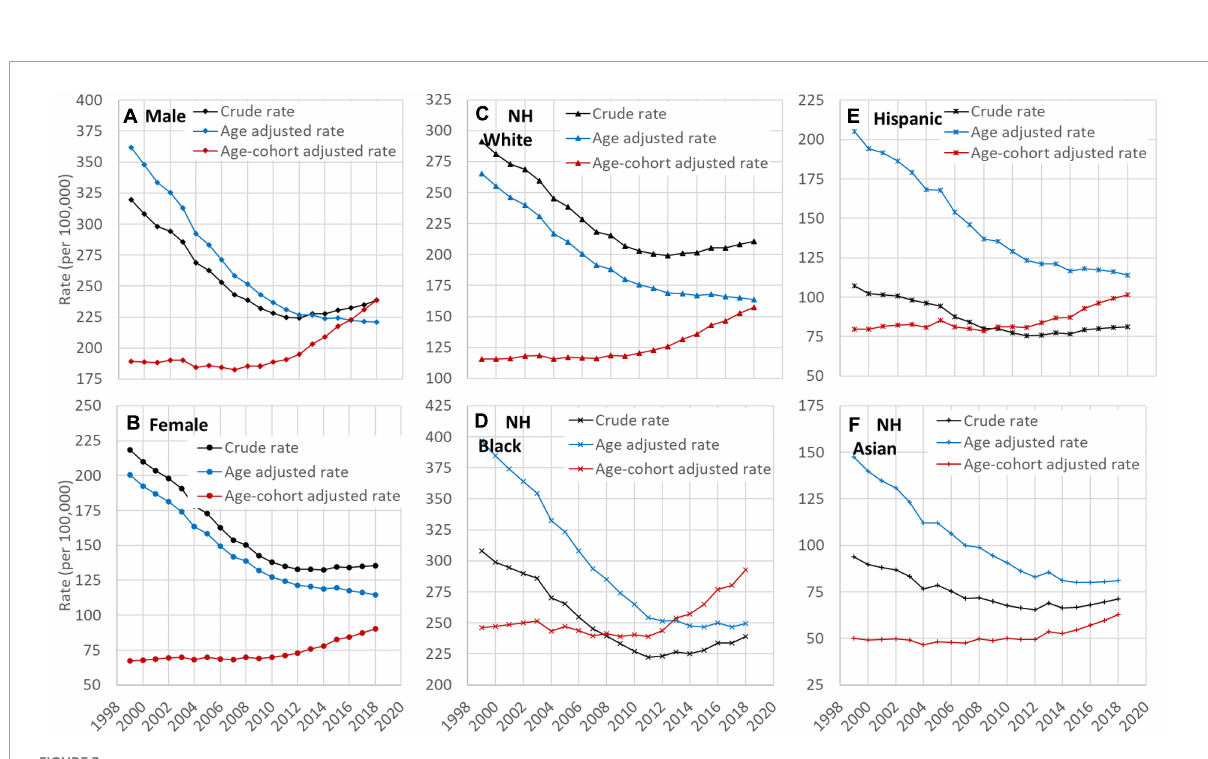
FIGURE3 Time trend of crude, age-adjusted, and age and cohort-adjusted rates of HD mortality among US adults, 25–84 years old, 1999–2018 by sex (A,B) and race (C–F) . HD: Heart disease; NH: Non-Hispanic. Data source: CDC WONDER